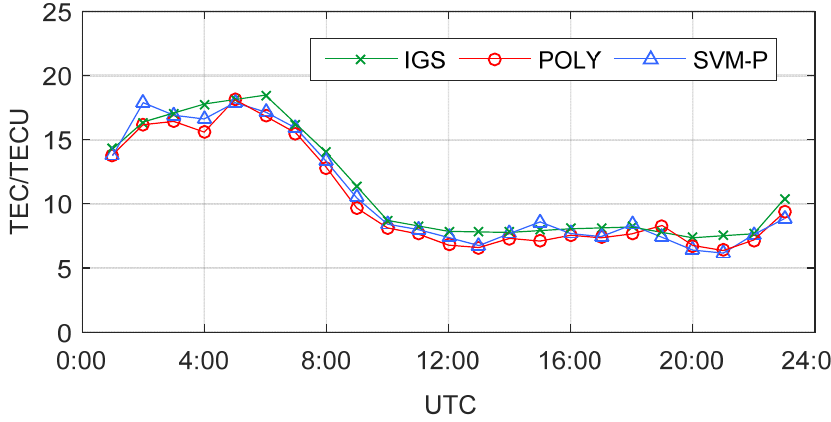
Figure 4. VTEC time series of IGS, polynomial (POLY), and Support Vector Machine Polynomial (SVM-P) in the regional center zenith direction.